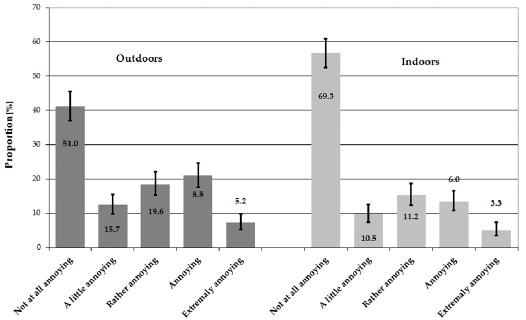
Figure 3. Results of assessment of annoyance due to the wind turbine noise on the 5-point verbal rating scale (outdoors and indoors) in total. Data are presented as proportions with 95% confidence intervals.